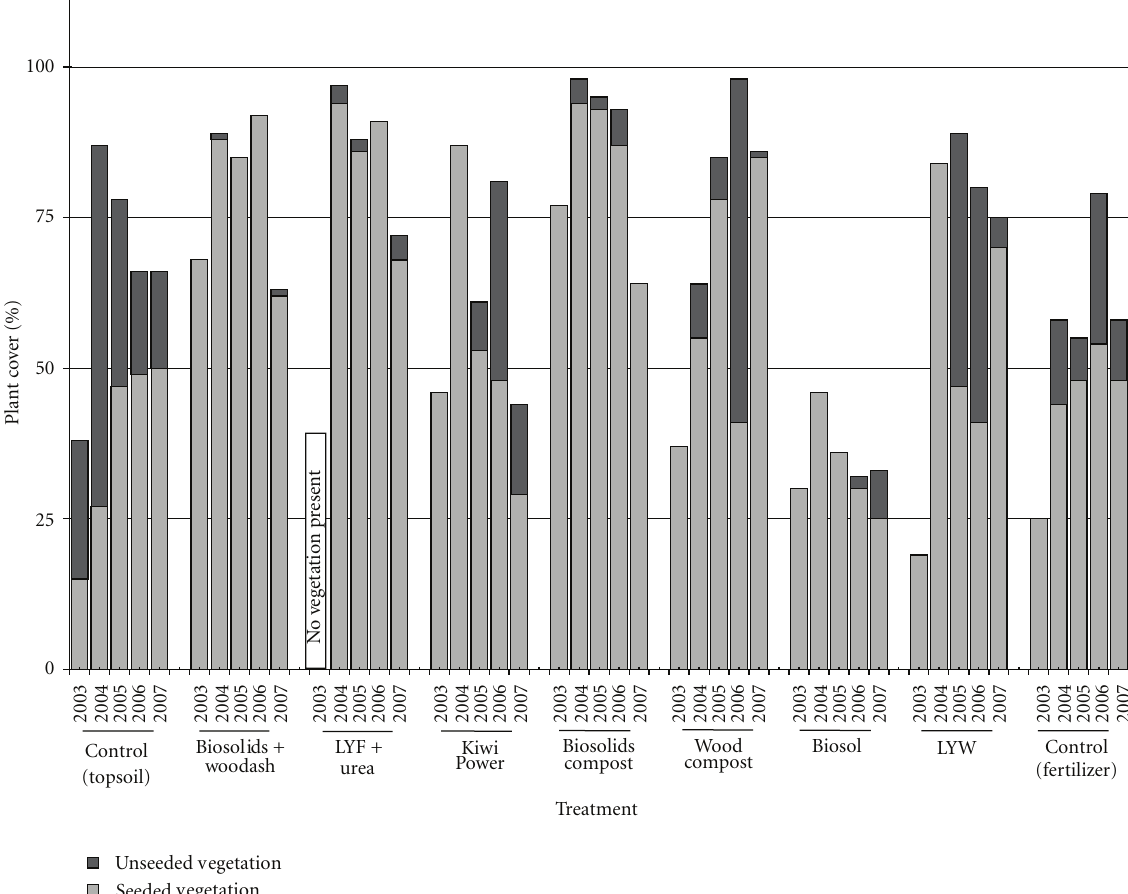
Figure 2: Comparison of total plant cover across all treatments for years 2003, 2004, 2005, 2006, and 2007.